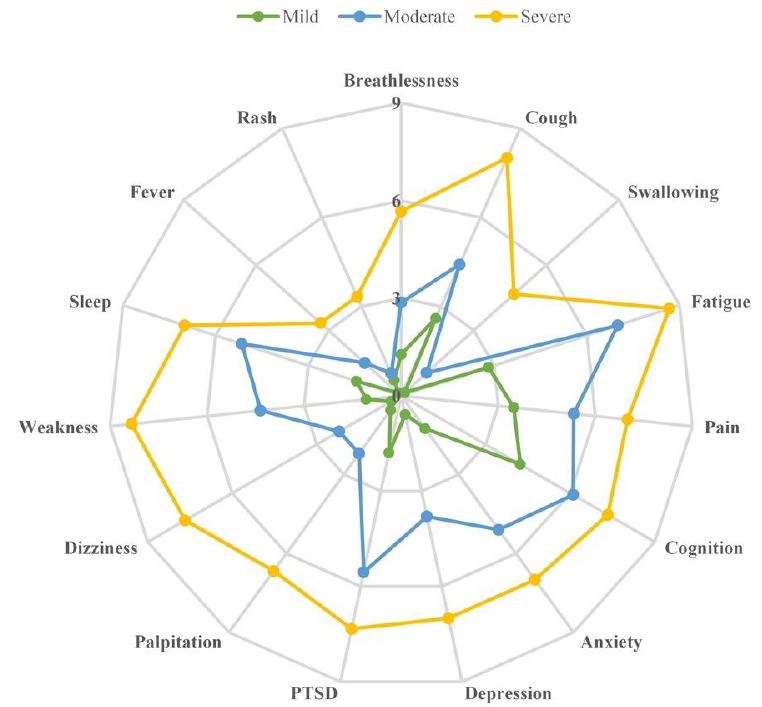
Figure 1. Radar plot of the mean severity of the 15 most prevalent Long COVID symptoms within each overall severity category, scored from 0 to 10. Notes: Based on the overall severity of the 15 symptoms, the three overall Long COVID severity categories were “severe” (with a mean symptom score of 6–10 scores), “moderate” (with a mean symptom score of 3–5.9 scores), and “mild” (with a mean symptom score of 0–2.9 scores).